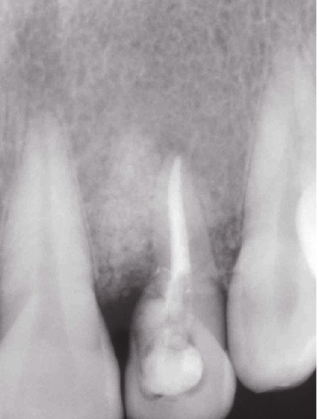
Figure 7: 12 months’ follow-up radiograph indicated disappearance of the radiolucency around the tooth #10 due to bone grafting and simultaneous bone